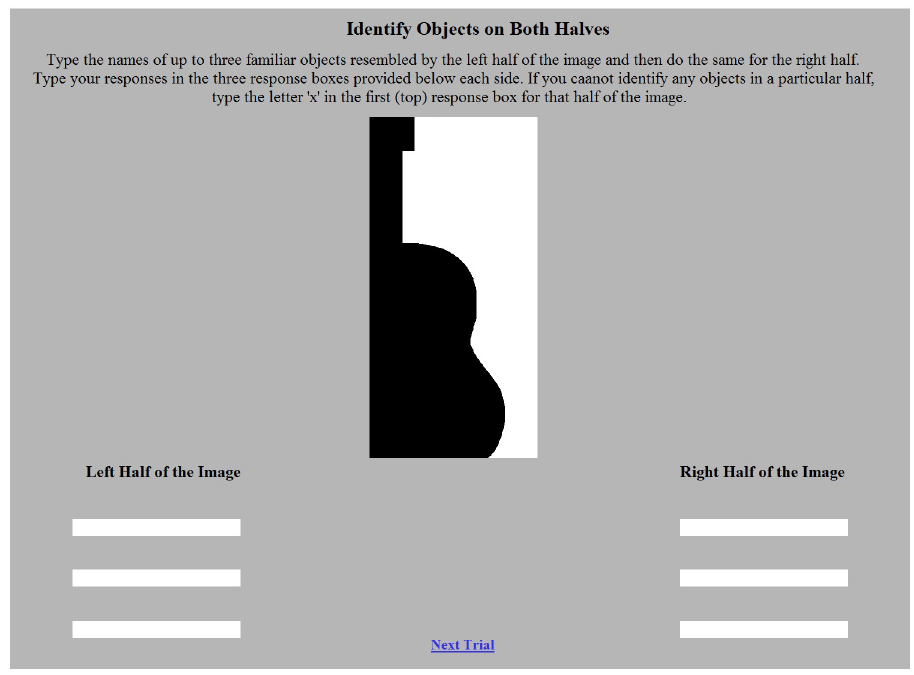
Fig 2. A sample trial. Participants were presented with a bipartite stimulus; here, an Upright Intact version of the source stimulus “guitar” sketched in black on the left of the central border. Six response boxes were provided (three per side). Participants used these boxes to list any familiar objects resembled by each side of the stimulus. A button labelled ‘Next Trial’ would lead them to the next trial when they were